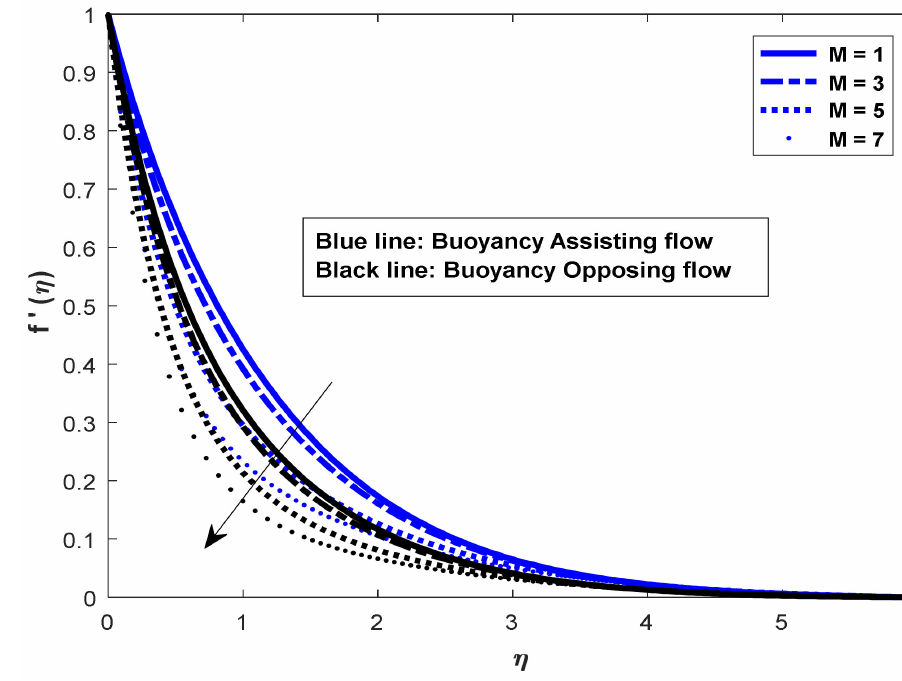
Figure 1. M on velocity.